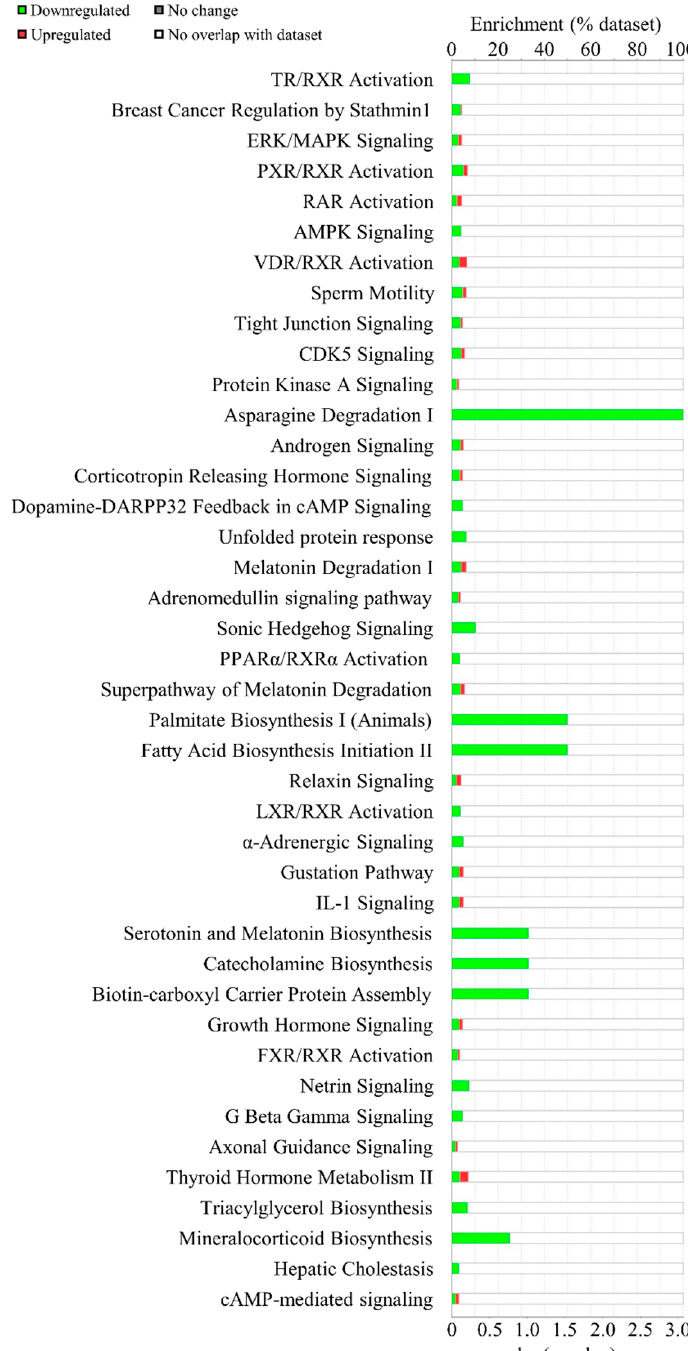
Figure 3. Canonical pathway analysis using Ingenuity Pathway Analysis software. Enriched canonical pathways in IDH2 KO mice liver were listed. The green bars indicate the number of downregulated genes while the red portion in bars show the number of upregulated genes.